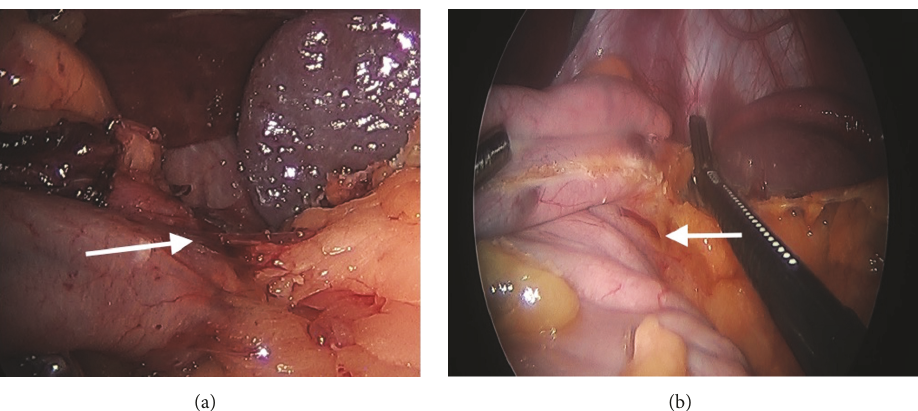
Figure3:(a)Preservingtheproximalposteriorattachmentsandbloodsupplytothesleeve.(b)Preservingtheproximalposteriorattachments and blood supply to the sleeve.